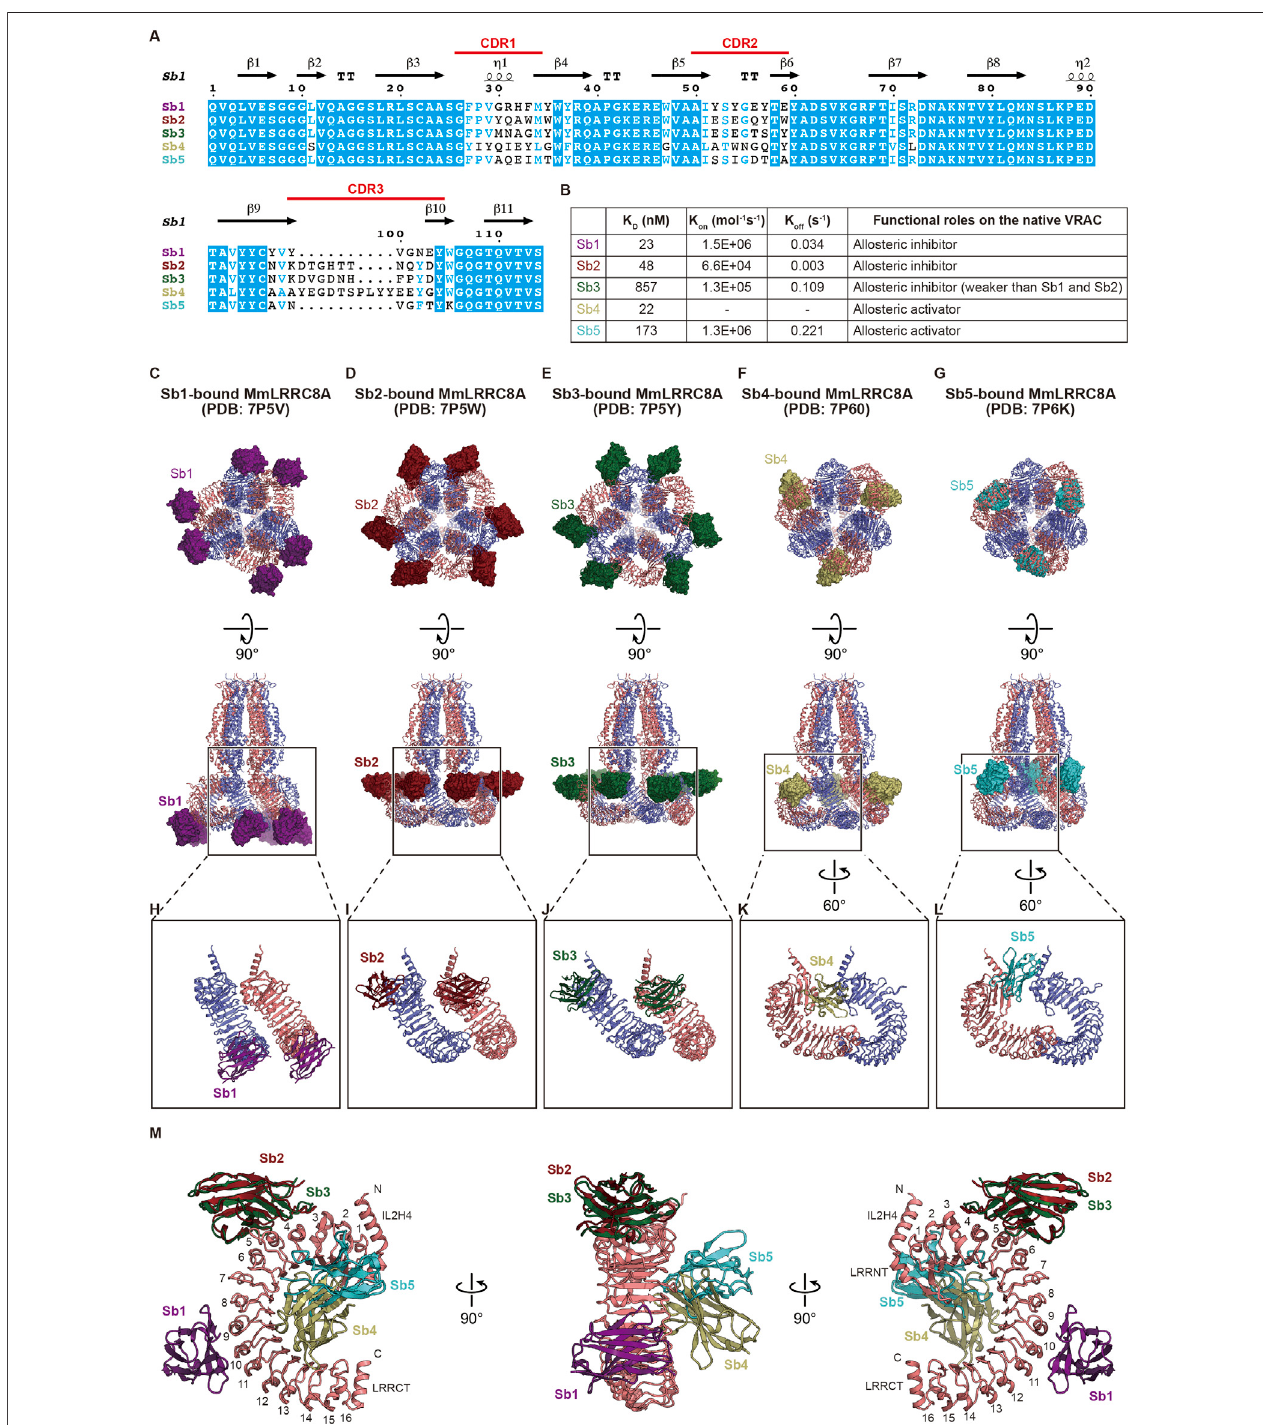
FIGURE 4 | Modulation of the LRR region. (A) Sequence alignment of the fi ve sybodies screened by Deneka et al.(Deneka et al., 2021). The secondary structure elementsfromSb1(PDB:7P5V)(Denekaetal.,2021)andtheircomplementarity-determiningregions(CDR)arelabeledabovethealignments (B) Summaryofthekinetic and dissociation constants as well as functional roles on the native VRAC current in each sybody. The kinetic and dissociation constants were the average of two independent biological replicates obtained by surface plasmon resonance spectroscopy(SPR).For Sb4, theaverageK on and K off values were not obtained due to missingdatafromareplicate.Fordetailedinformation,see Table1 inDenekaetal.(Denekaetal.,2021) (C – G) OverallstructureoftheMmLRRC8Ahexamerincomplex with each sybody, viewed from the intracellular side (upper) and parallel to the membrane (lower). Each sybody is shown as the surface model and is colored as follows: